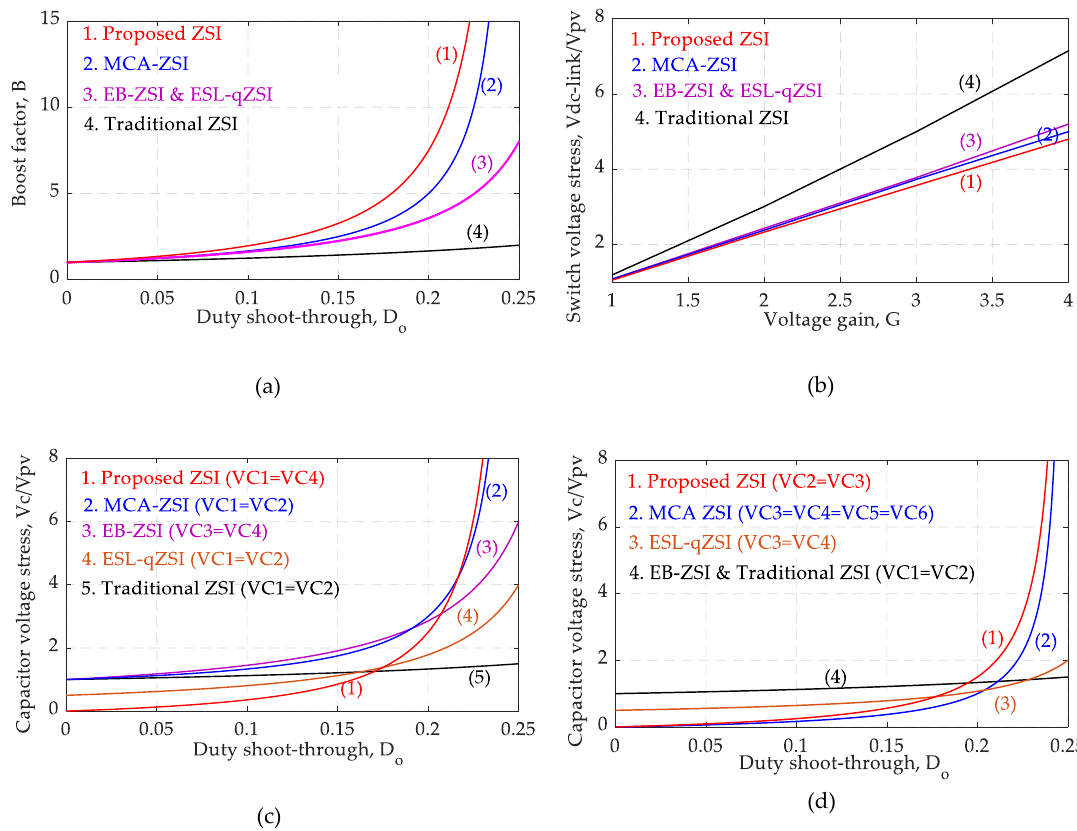
Figure 6. Characteristic curves of the SL-SBZSI: ( a ) duty ratio vs boost factor, ( b ) voltage gain vs switch voltage stress, ( c ) duty ratio vs capacitor voltage stress (high-stage), and ( d ) duty ratio vs capacitor voltage stress (low-stage).